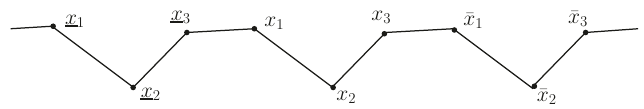
Figure 1. Dual periodic Wilson line configuration for the three-point form factor.